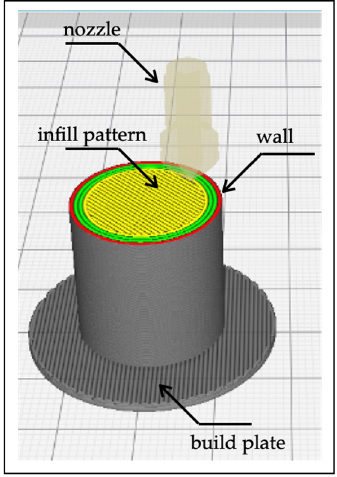
Figure 2. Specimen fabrication.